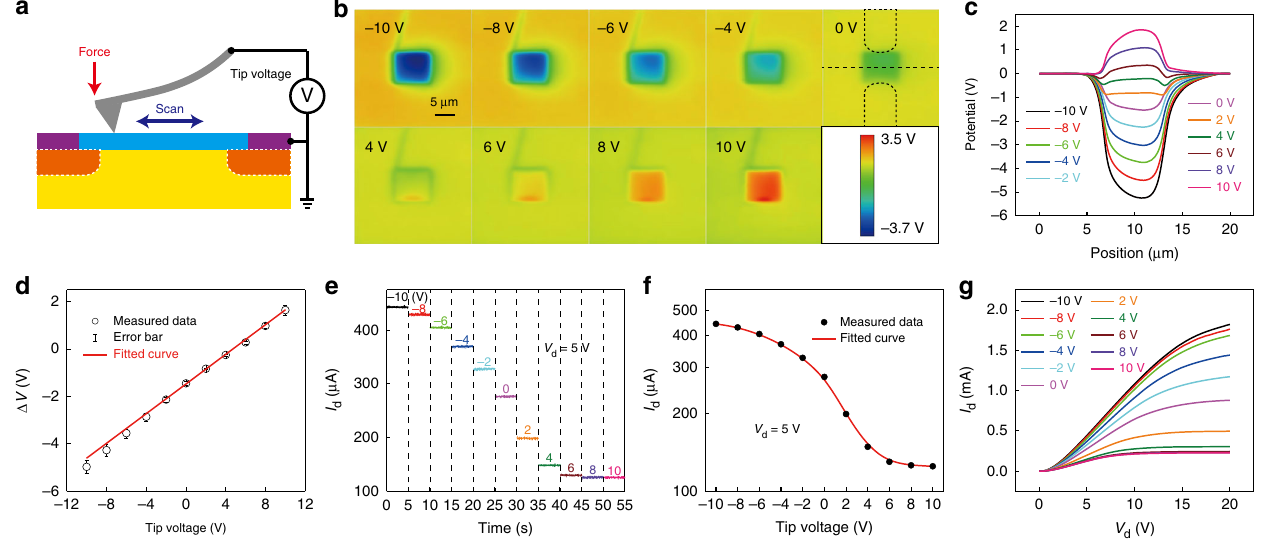
Fig. 5 The rewritable fl oating gate for the NTT by applying a tip voltage. a Schematic illustration of applying a tip voltage during the process of nanoscale triboelectri fi cation. b Surface potential distributions of the NTT after regionally rubbed by the AFM tip with different tip voltages. c Corresponding potential distributions in cross-sectional view with different tip voltages. d The potential difference between the rubbed and surrounding area with different tip volltages. e I d output characterisics at a drain voltage of 5 V with different tip voltages from − 10 V to 10 V. f The I d – V T transfer characteristics. g I d – V d output characteristics with different tip